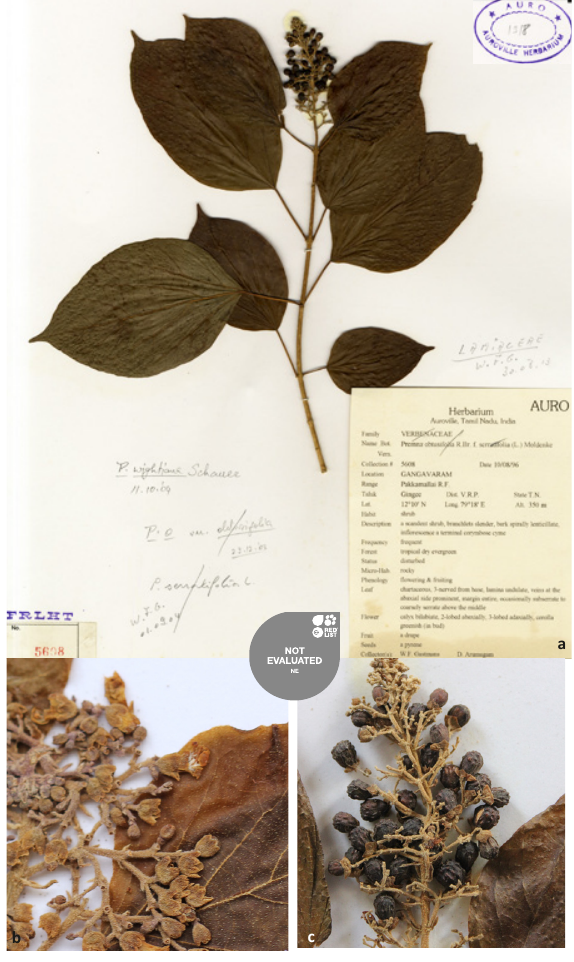
Image 3. Premna wightiana a - Fruiting body; b - Flower, c -